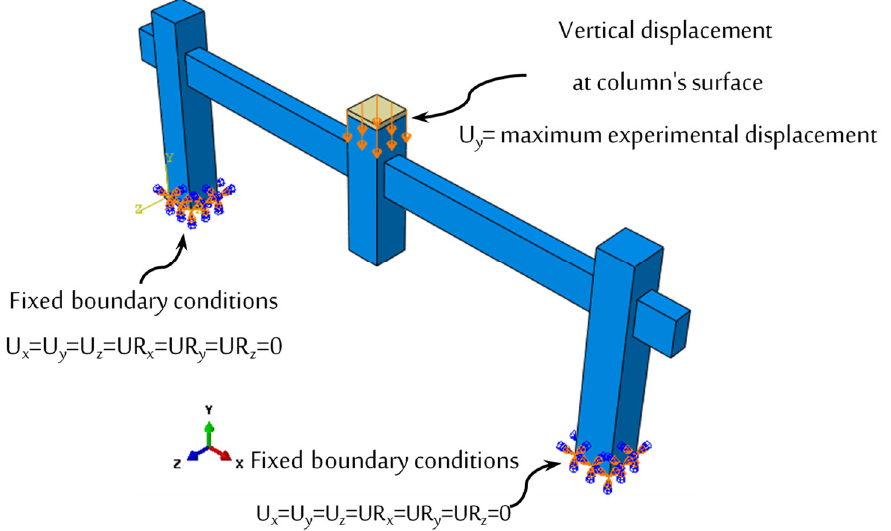
Figure 9. Boundary conditions and loading of tested frame specimens.